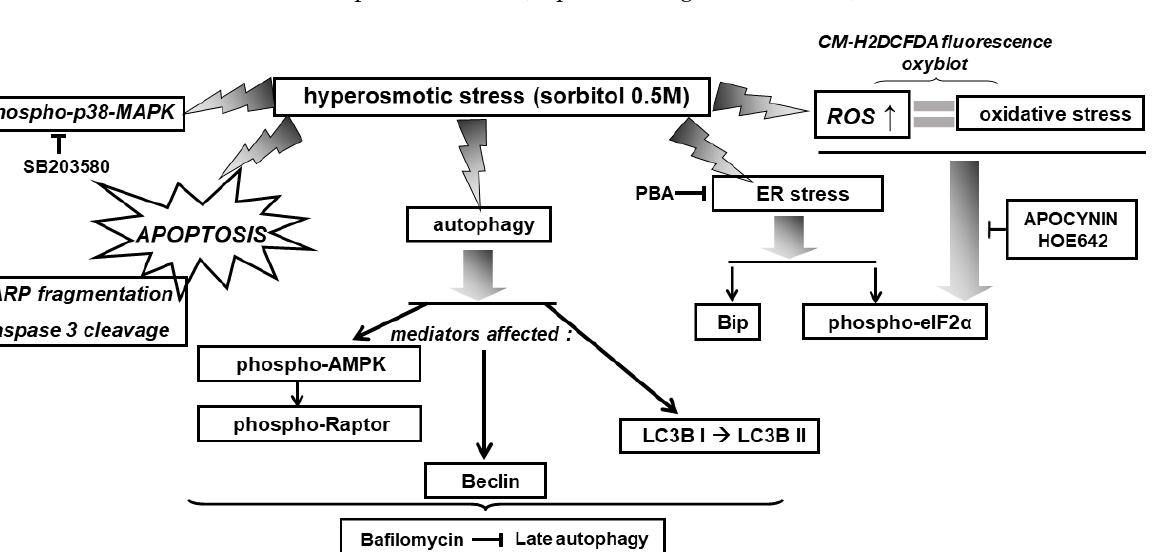
Figure 15. Scheme depicting the effect of SB203580, bafilomycin and PBA on H9c2 cell viability under conditions of hyperosmotic stress. enhancement,